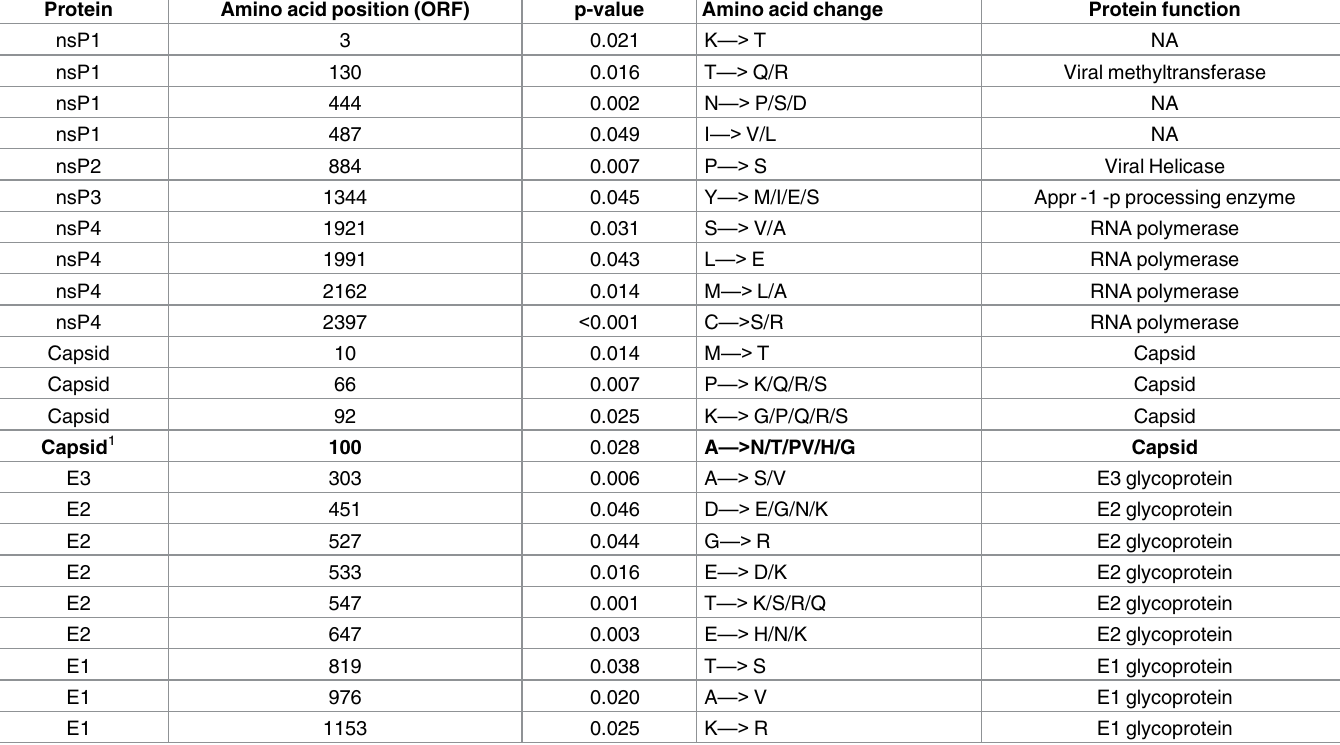
Table 2. Codon positions predicted to be under episodic positive selection, showing the amino acid changes and the proteins altered. Amino acid positionis definedusing the Genome sequence3908 (AccessionnumberU55350in the NCBI database) and numberedagainstthe non-structural and struc- tural